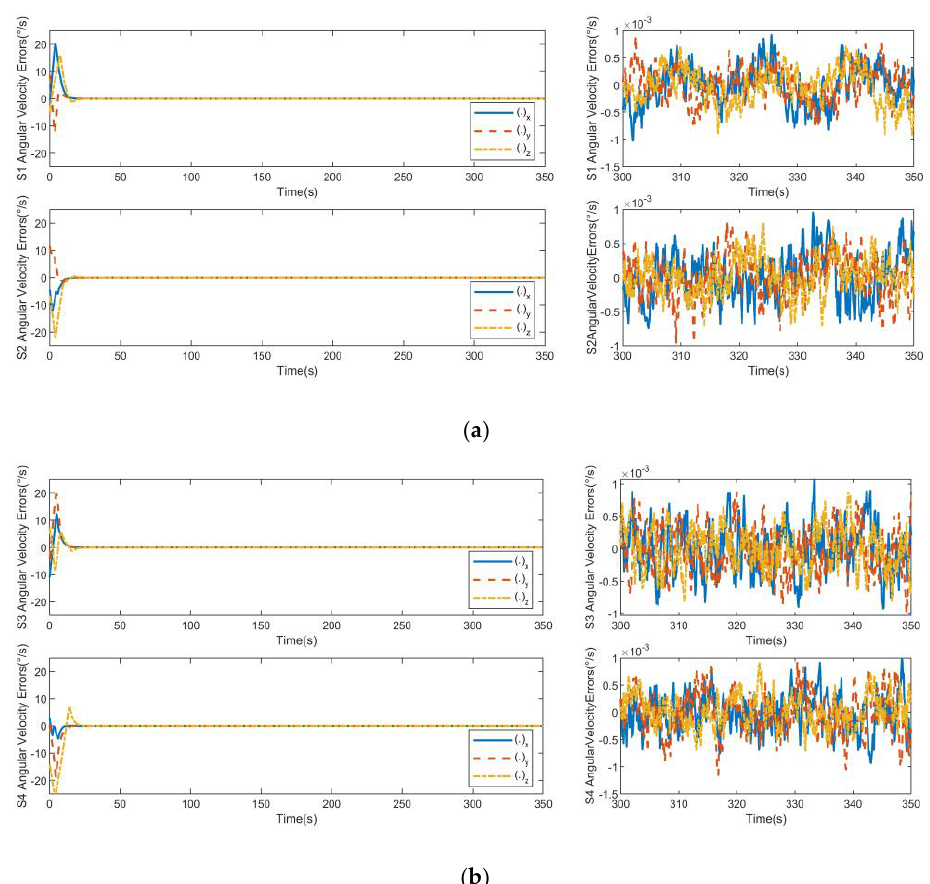
Figure 12. Angular velocity errors for consistent collaborative control : ( a ) S1 angular velocity errors and S2 angular velocity errors; ( b ) S3 angular velocity errors and S4 angular velocity errors.